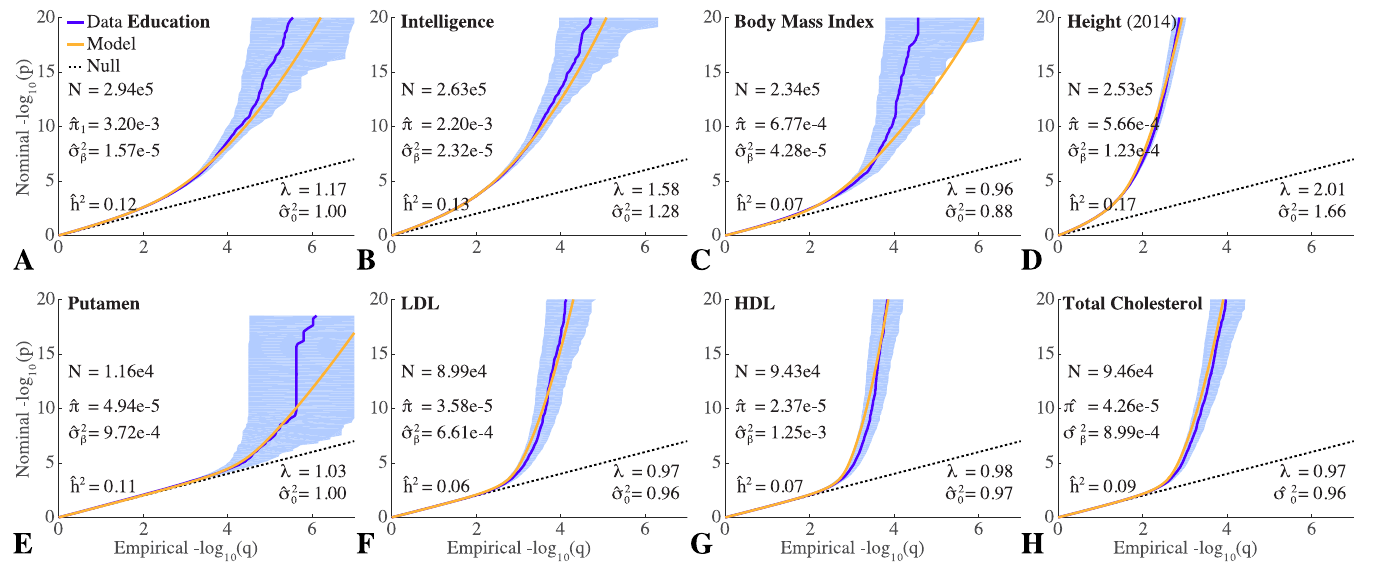
Fig 2. this area for notes QQ plots of (pruned) z-scores and model fits for quantitative phenotypes: (A) educational attainment; (B) intelligence; (C) body mass index (BMI); (D) height; (E) putamen volume; (F) low-density lipoprotein (LDL); (G) high-density lipoprotein (HDL); and (H) total cholesterol (TC). N is the sample size. See Fig 1 for further description. Numerical values for the model parameters are also given in Table 2. See also S1 Appendix (pp. S29-S38).